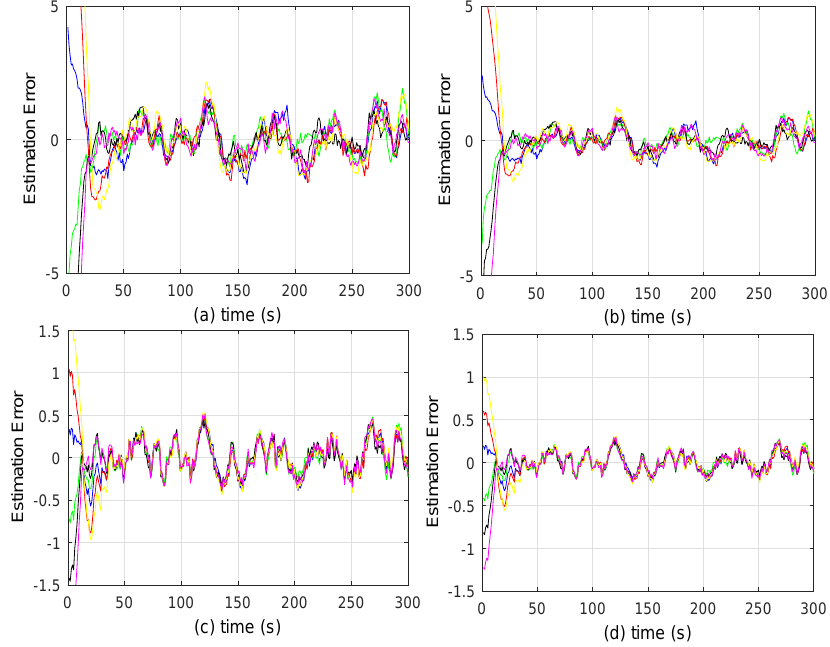
Figure 3. Performance of agents with random sleep scheme. ( a – d ) represent the estimation error of x k ( 1 ) , x k ( 2 ) , x k ( 3 ) and x k ( 4 ) , respectively.